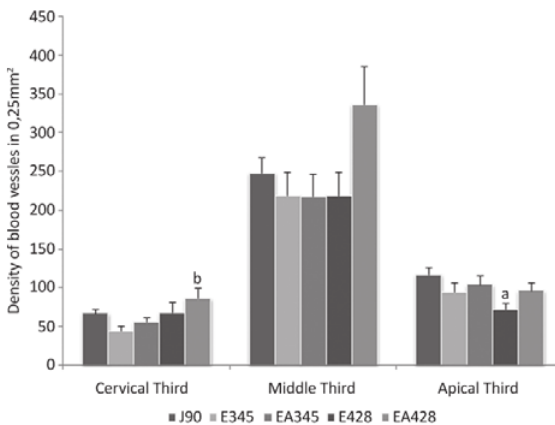
Figure 4 - Density of blood vessels in cervical, middle and apical thirds of the root observed in groups: J90 (90-day-old young rats), E345 (345-day-old aged rats), EA345 (345-day-old aged rats treated with ascorbic acid since 90-day-old), E428 (428-day-old aged rats) and EA428 (428-day-old aged rats treated with ascorbic acid since 90-day-old). n = 5 rats per group. a P < 0.05 when compared to group J90, b P < 0.05 when compared to group